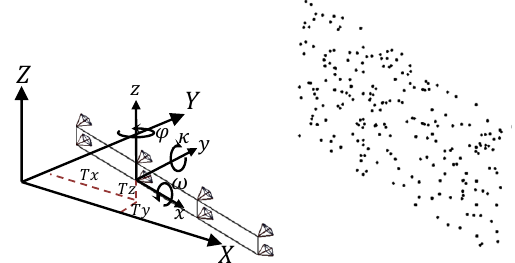
Figure 2. Camera and object coordinate systems